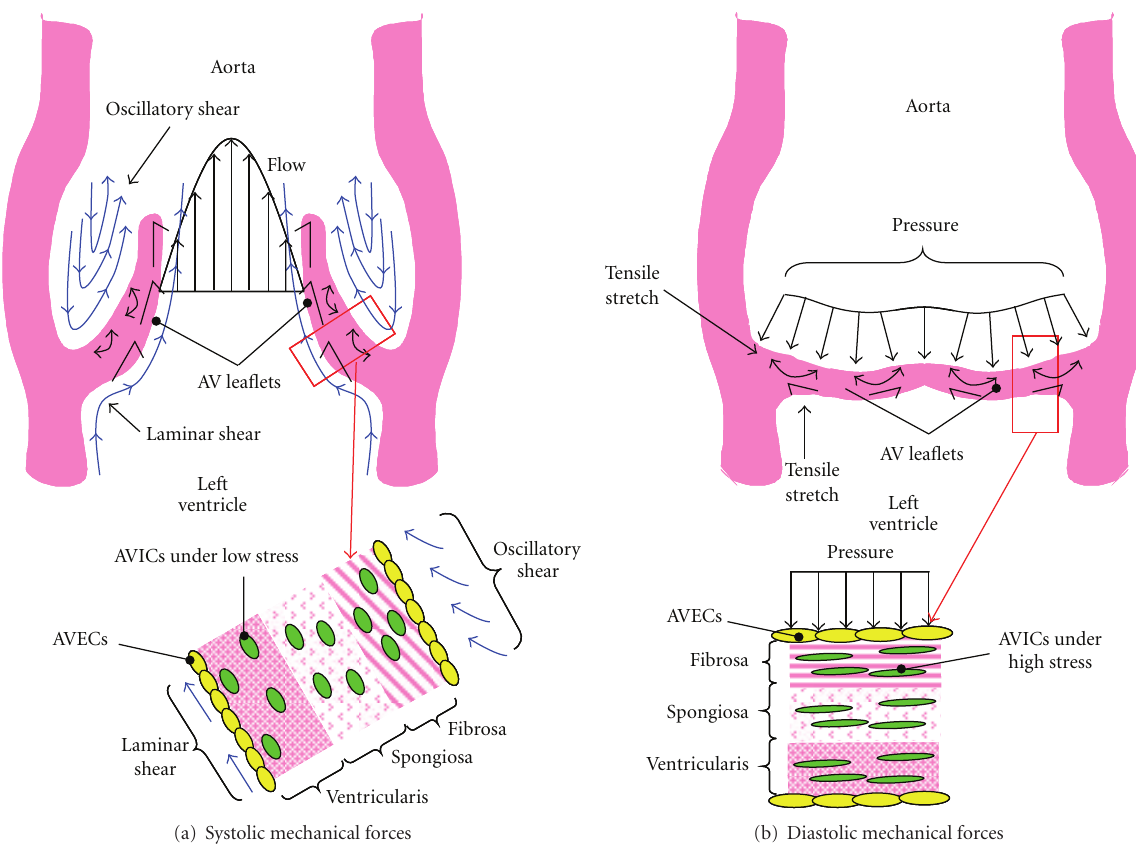
Figure 1: Schematic of mechanical forces experienced by the aortic valve during peak systole (a), and peak diastole (b). Insets depict qualitatively the e ff ect of these forces on valve cells.